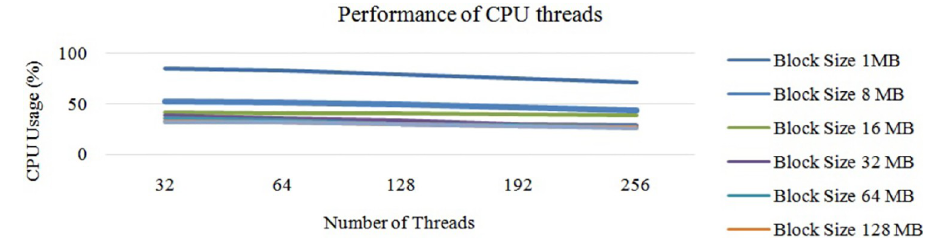
Fig 17. Performance of CPU threads at 2 map tasks allocated to each task at maximum on single DataNode.